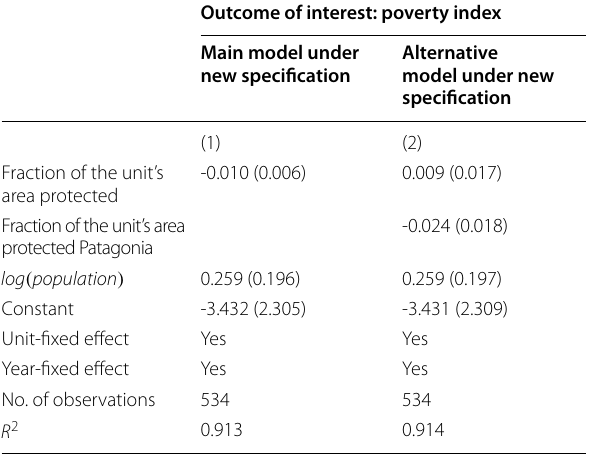
Table 3 Estimated effects of protected areas on poverty in Chile. The main explanatory variable is a continuous variable equal to the fraction of the unit’s area that is protected